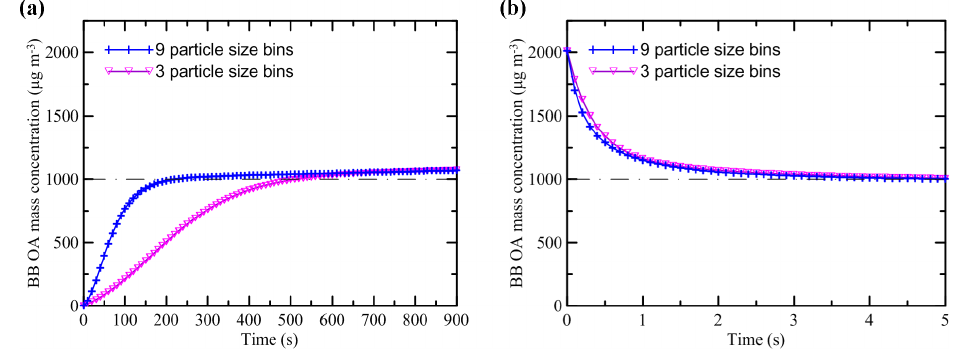
Figure 5. Adjustment of mass concentration of fresh BB OA to thermodynamic equilibrium according to test simulations performed with the S15 scheme without dilution. The simulations were initiated from different initial conditions: (a) C 0 = 0µgm 3 and (b) C 0 = 2 × 10 2 µgm 3 . A horizontal dashed–dotted line in each panel indicates the BB OA concentration (10 3 µgm 3 ) at thermodynamic equilibrium. The time step in the test simulations was set at